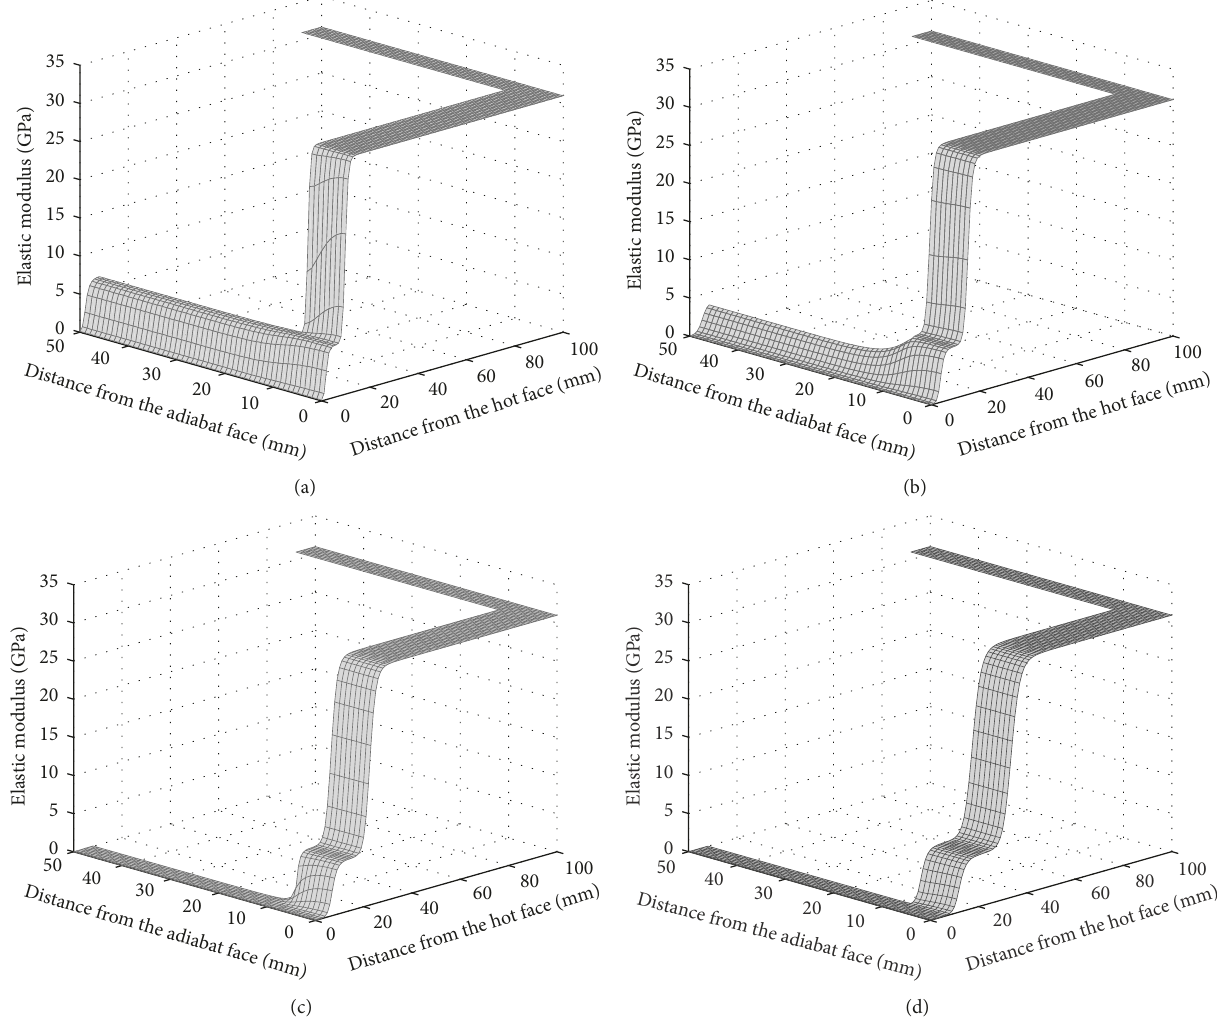
Figure 5: Elastic modulus distribution of GFRP tube: (a) 5min, (b) 10 min, (c) 20 min, and (d)